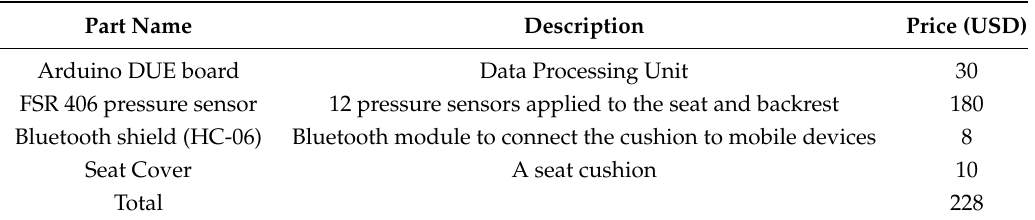
Table 3. List of the components required by the prototype